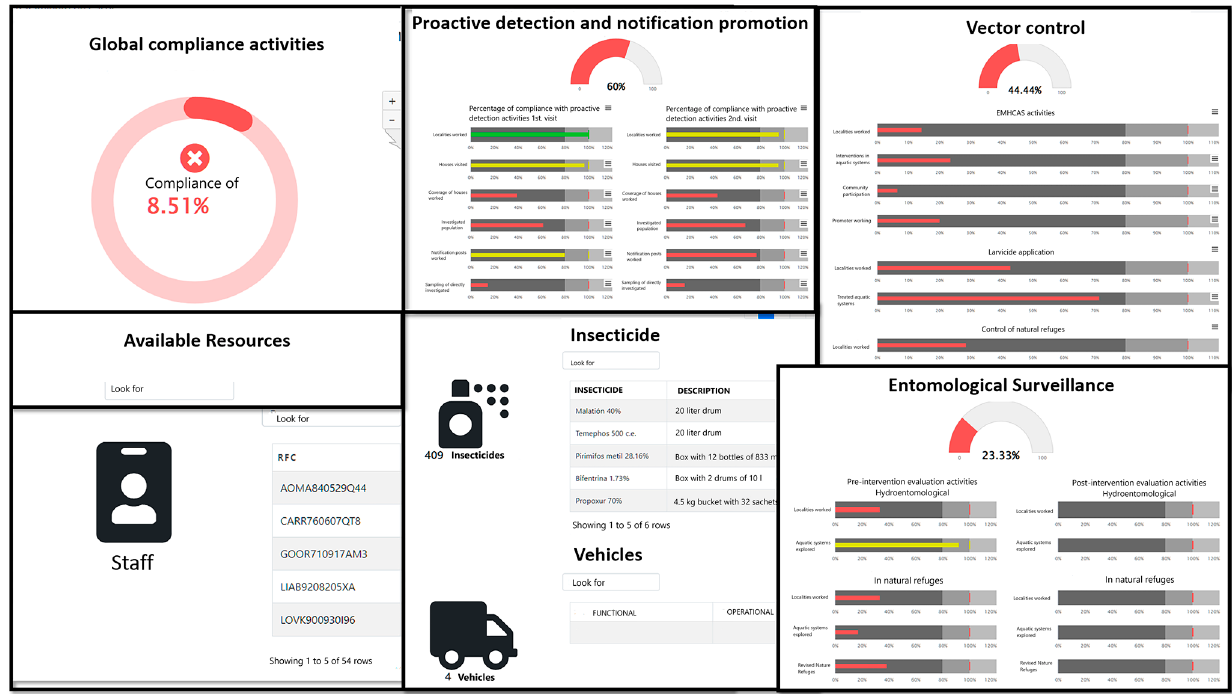
Figure 7. Dashboard . Indicators for monitoring the activity of notification, detection, promotion, vector control, and entomological surveillance. The dashboard indicators are calculated using data that the jurisdictional office routinely enters into the system. The categories of compliance of the activities are divided into Not carried out when it is 0%, Insufficient from 1 to 79.9% (red color), Acceptable from 80 to 99.9% (yellow color) and Optimum from 100% (green color).